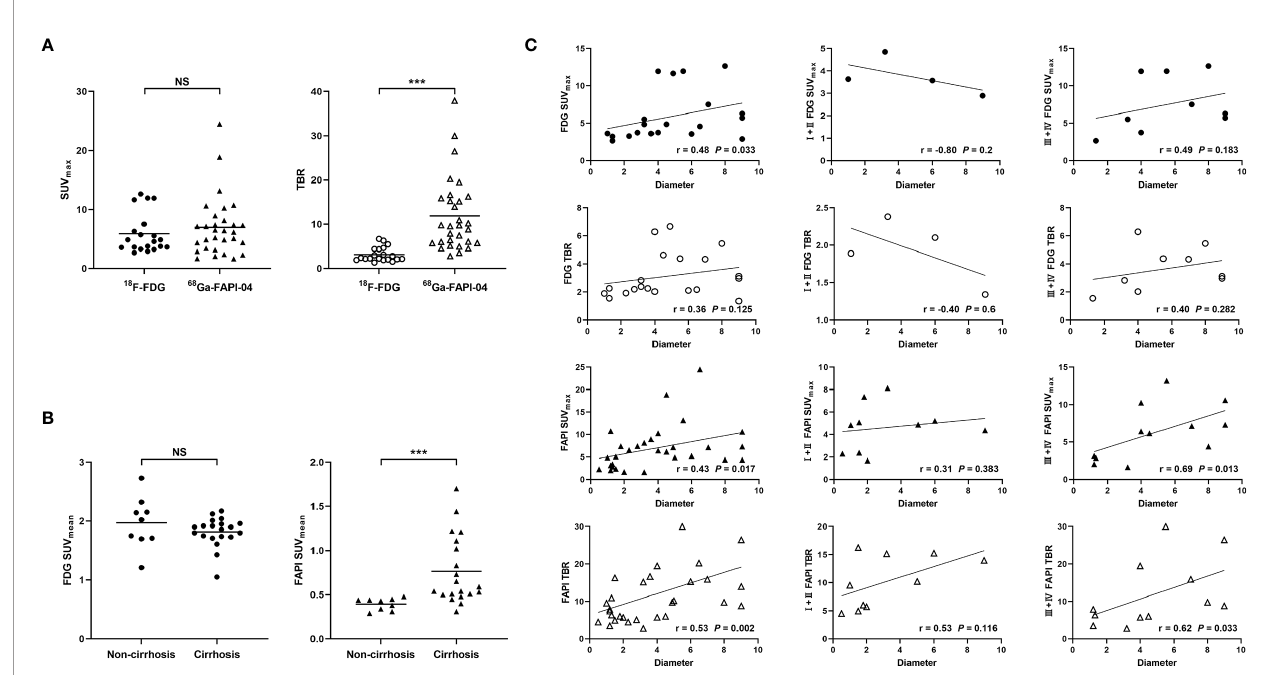
FIGURE 3 | (A) Comparison of uptake intensity (SUV max and TBR) between 18 F-FDG and 68 Ga-FAPI-04. (B) Comparison of background uptake (SUV mean ) between patients with cirrhosis or those without cirrhosis. (C) Spearman rank correlation analysis of uptake intensity (SUV max and TBR) and tumour diameter in 18 F-FDG and 68 Ga-FAPI-04. NS, not statistically signi fi cant; ***, P <